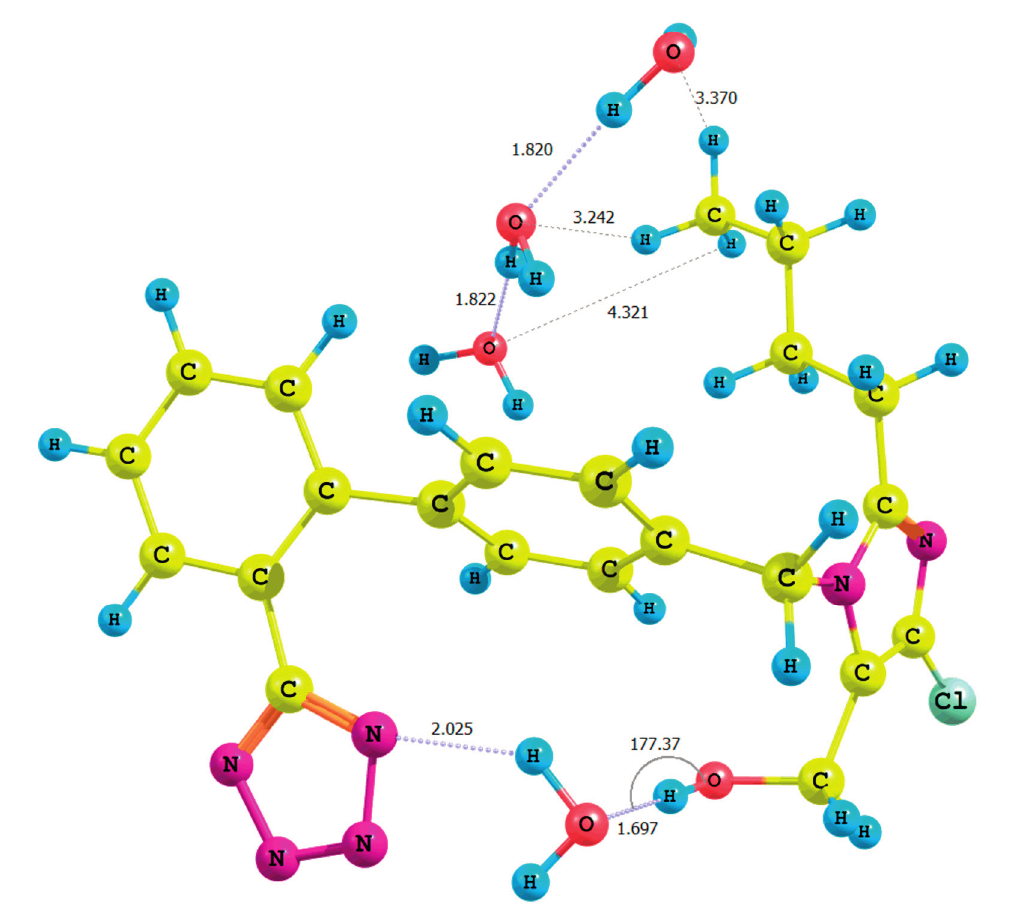
Figure 5. Optimized structure of the anti -losartan anion cluster 1 with water molecules (Cluster XVI ); interaction of 1 with three water molecules (PBE1PBE/6-31G(d,p) level of theory,